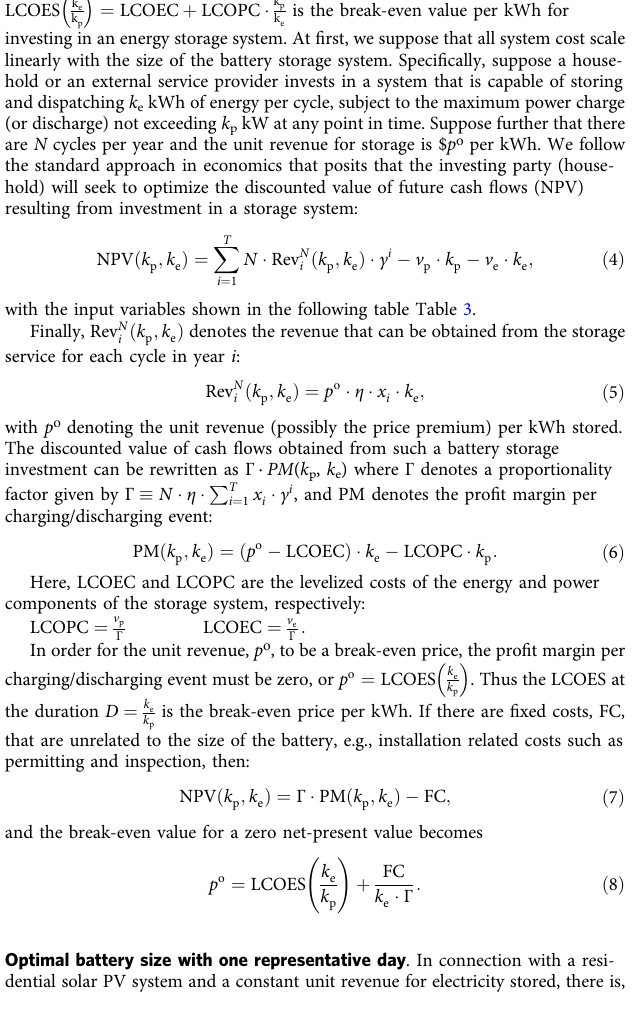
Table 3 Input variables for the NPV expression v p System Price of power components (in $ per kW) v e System price energy component (in $ per kWh) γ ¼ 1 Discount factor based on the discount rate r (scalar) 1 þ r T Useful Life of the battery system (in years) x i Storage degradation factor (scalar) η Round-trip ef fi ciency factor of the storage system (scalar) N Number of charge and discharge cycles per year